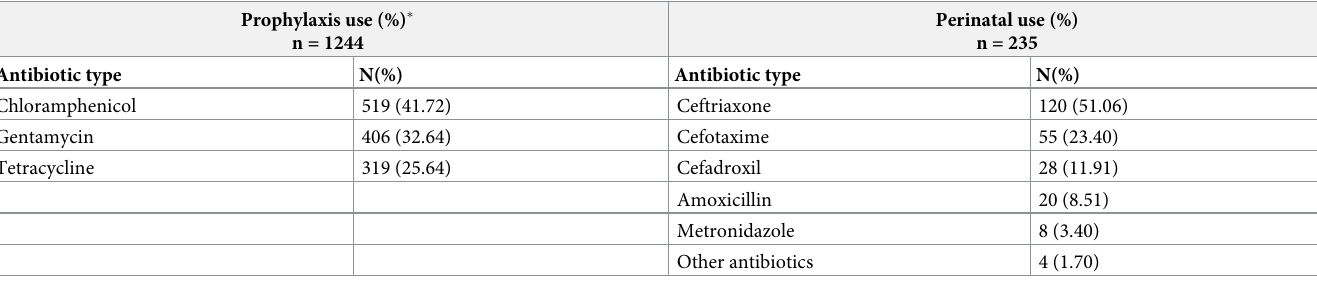
Table 5. List of antibiotic prophylaxis and perinatal